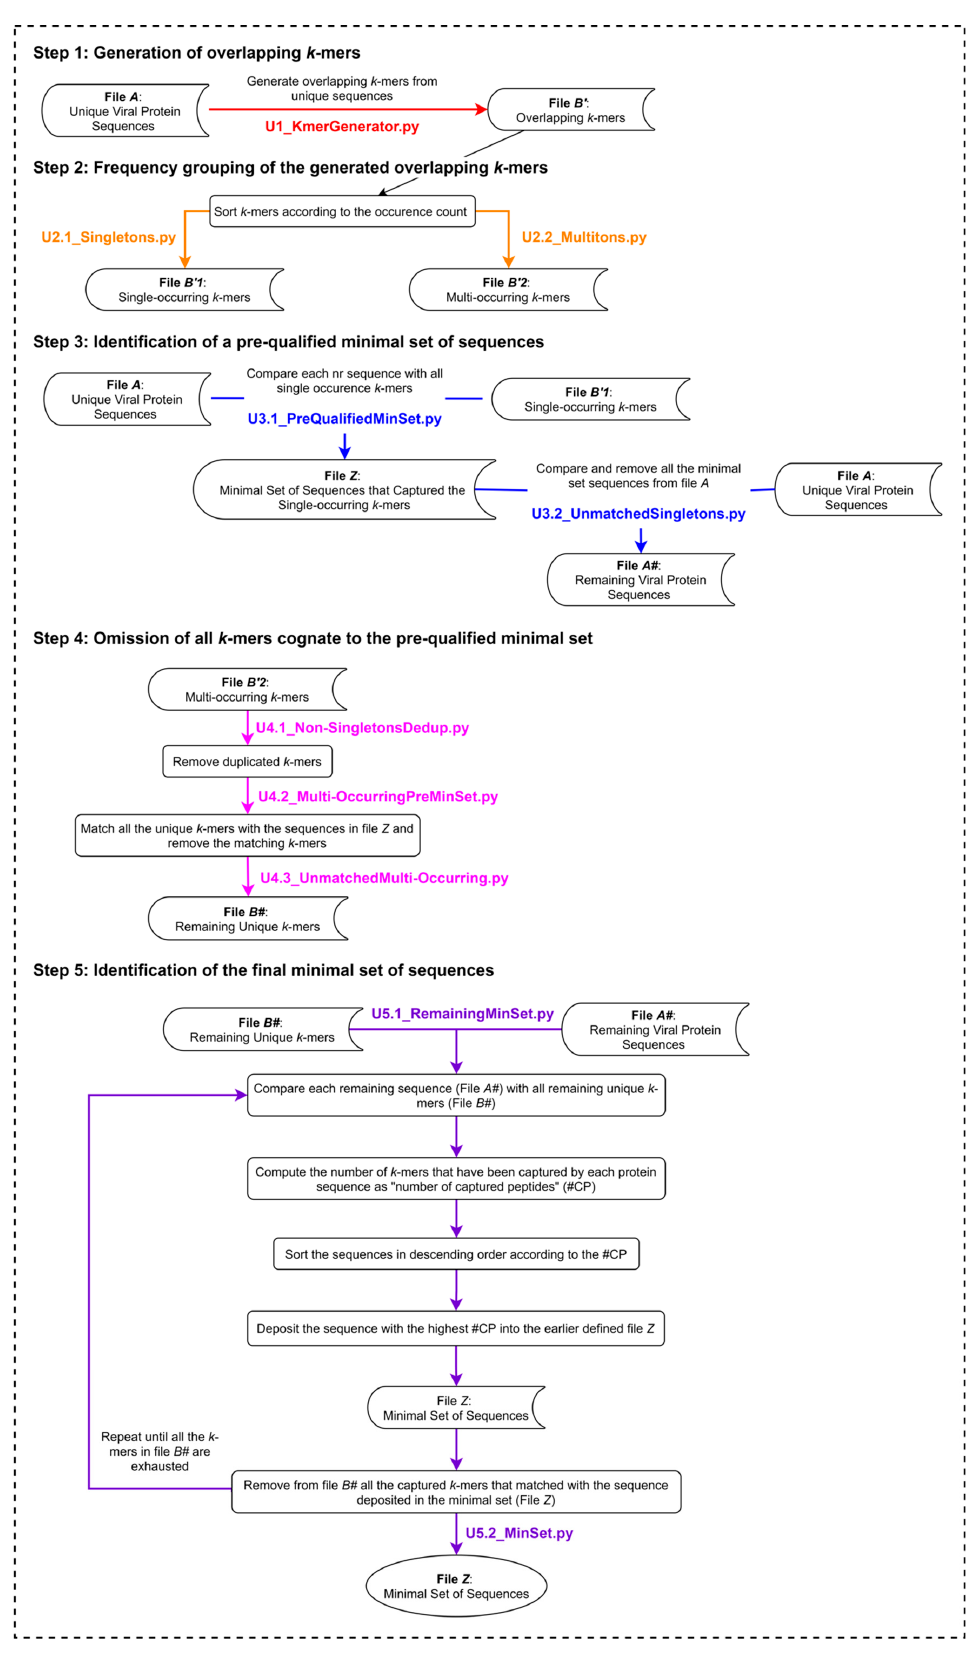
Figure 2. The UNIQmin algorithm. Abbreviation: nr,